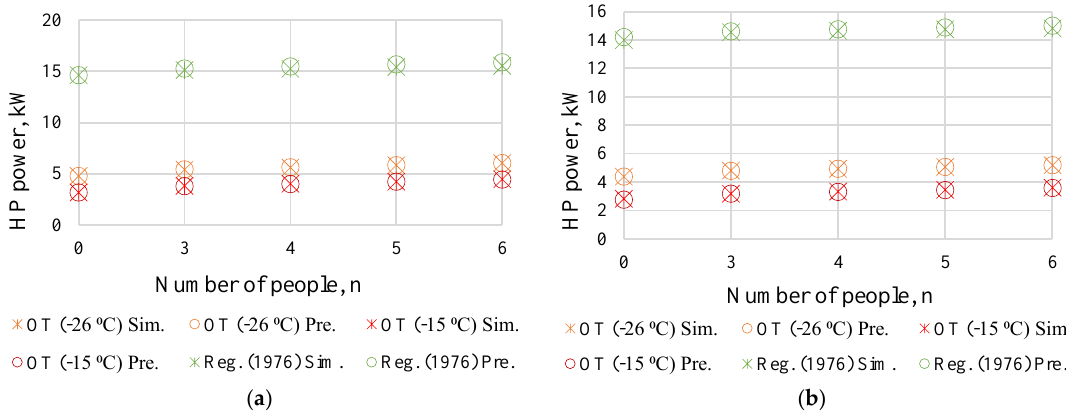
Figure 17. Simulated and predicted GSHP powers ( a ) for space and DHW heating without consideration of internal gains, ( b ) for space and DHW heating with consideration of internal gains. (OT ( − 26 °C) Sim. refers to simulated results with an outdoor temperature of − 26 °C, OT ( − 26 °C) Pre. refers to predicted results with an outdoor temperature of −26 °C , Reg. (1976) Sim. refers to simulated results for a building that built according to old building regulations of 1976).